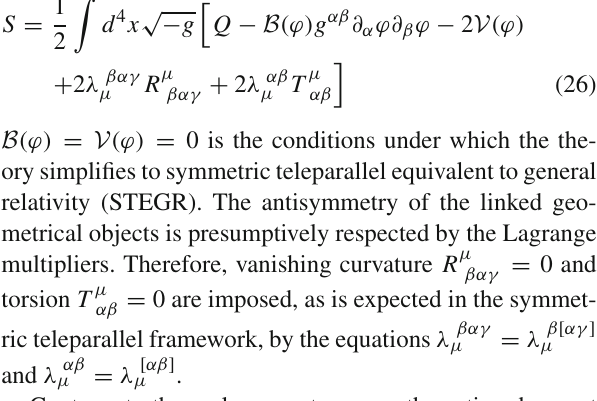
Fig. 1 Evolutionary behaviour of Hubble radius in cosmic